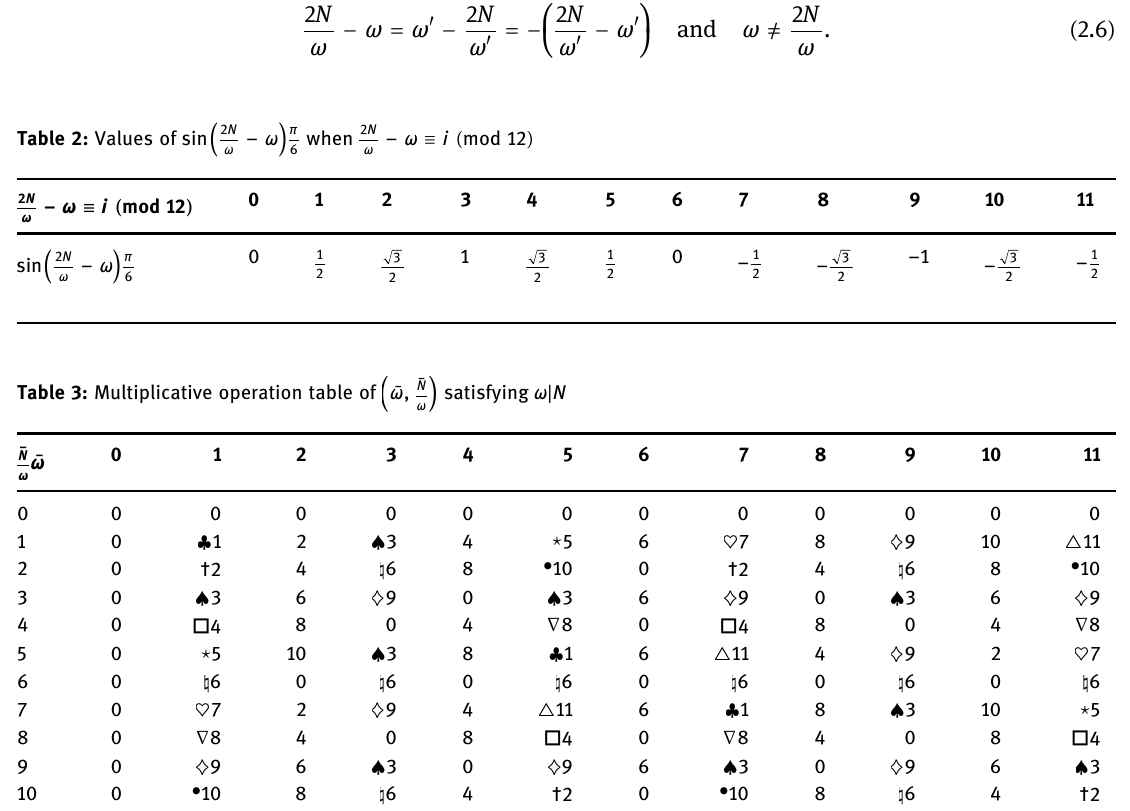
Table 2: Values of